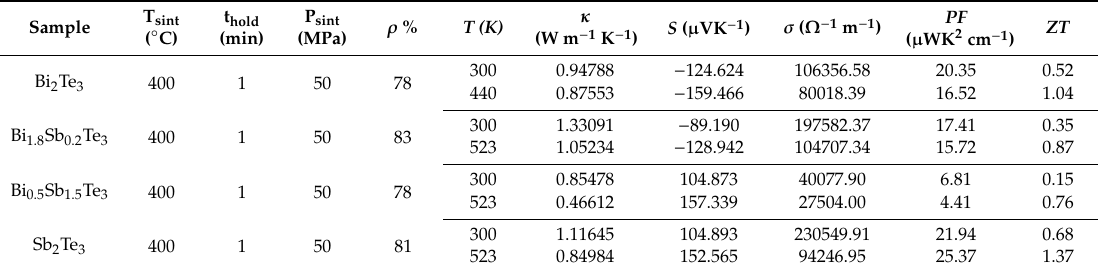
Table 2. SPS parameters and transport properties for nanostructured bulk Bi 2 − x Sb x Te 3 :